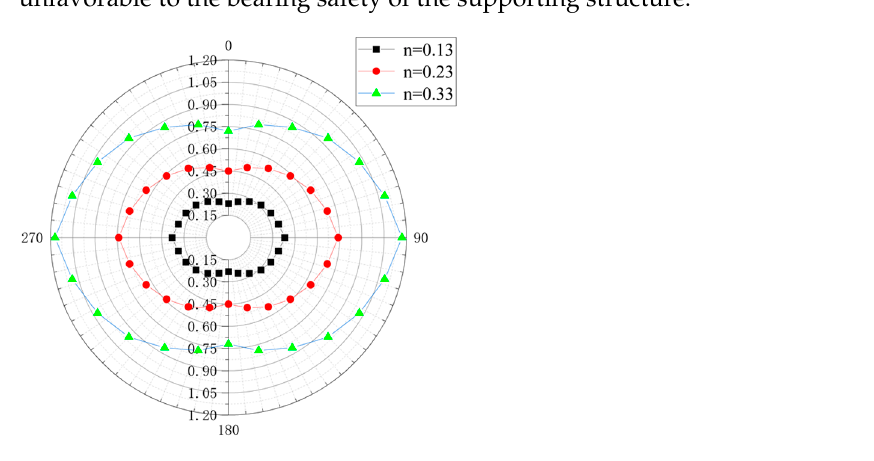
Figure 9. Annular distribution of the frost heave force of rock mass with different water content.